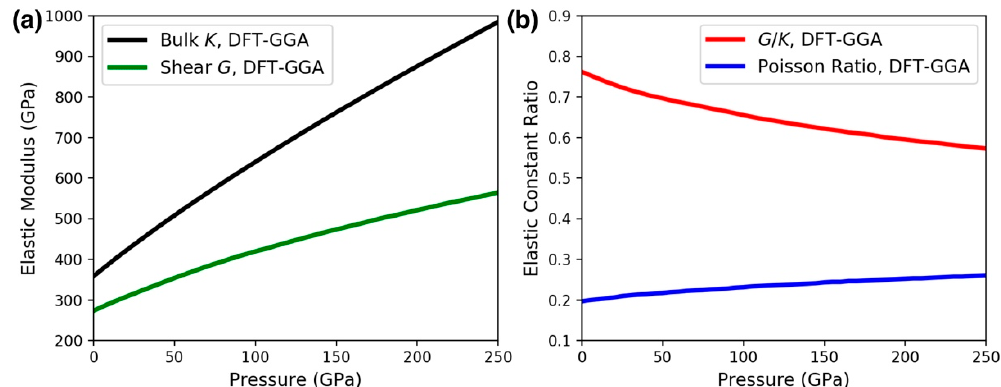
Figure 6. ( a ) Bulk ( K ) and shear ( G ) moduli for ReB 2 as a function of pressure. The elastic moduli were obtained using the elastic constants computed by density functional theory (DFT) with the generalized gradient approximation (GGA) functional and the Voigt–Reuss–Hill approximation. ( b ) The G/K ratio and the Poisson ratio = (3 K − 2 G )/[2(3 K + G )], showing that the material became more ductile with increasing pressure.